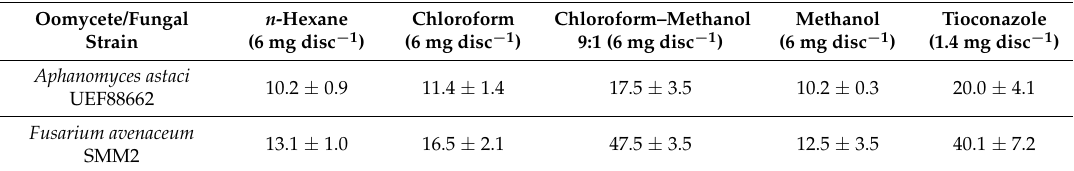
Table 1. Anti-oomycete and antifungal activity of different Zanthoxylum rhoifolium bark (Zr-b) extracts determined by the agar diffusion method a .